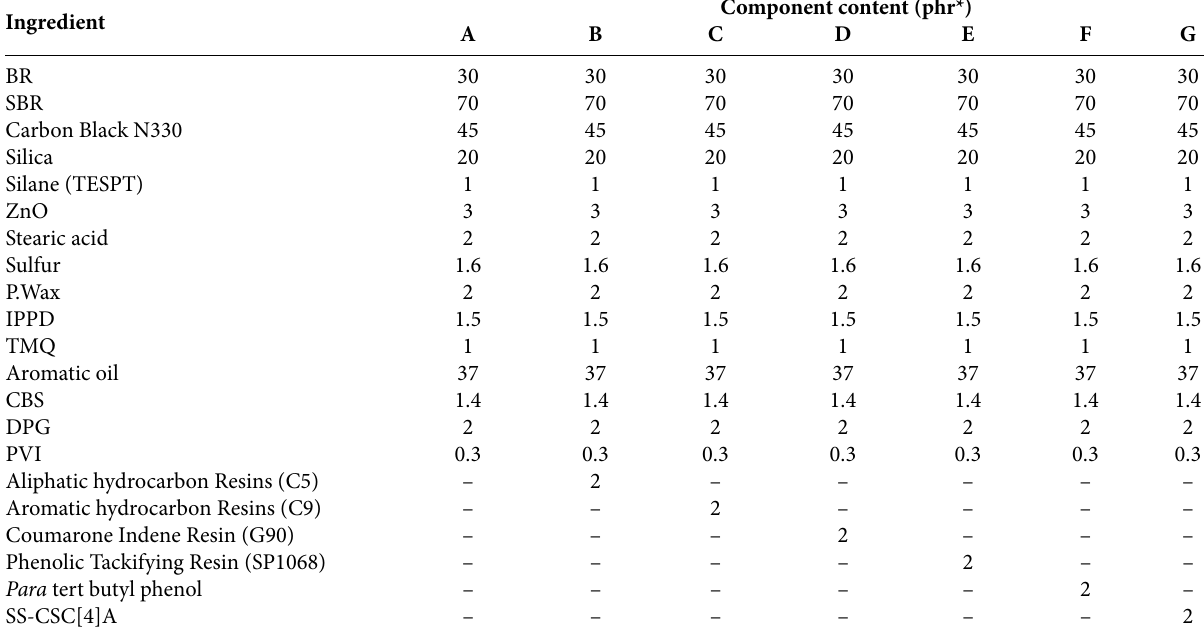
Table 2. Tire Tread Compound Formulations.